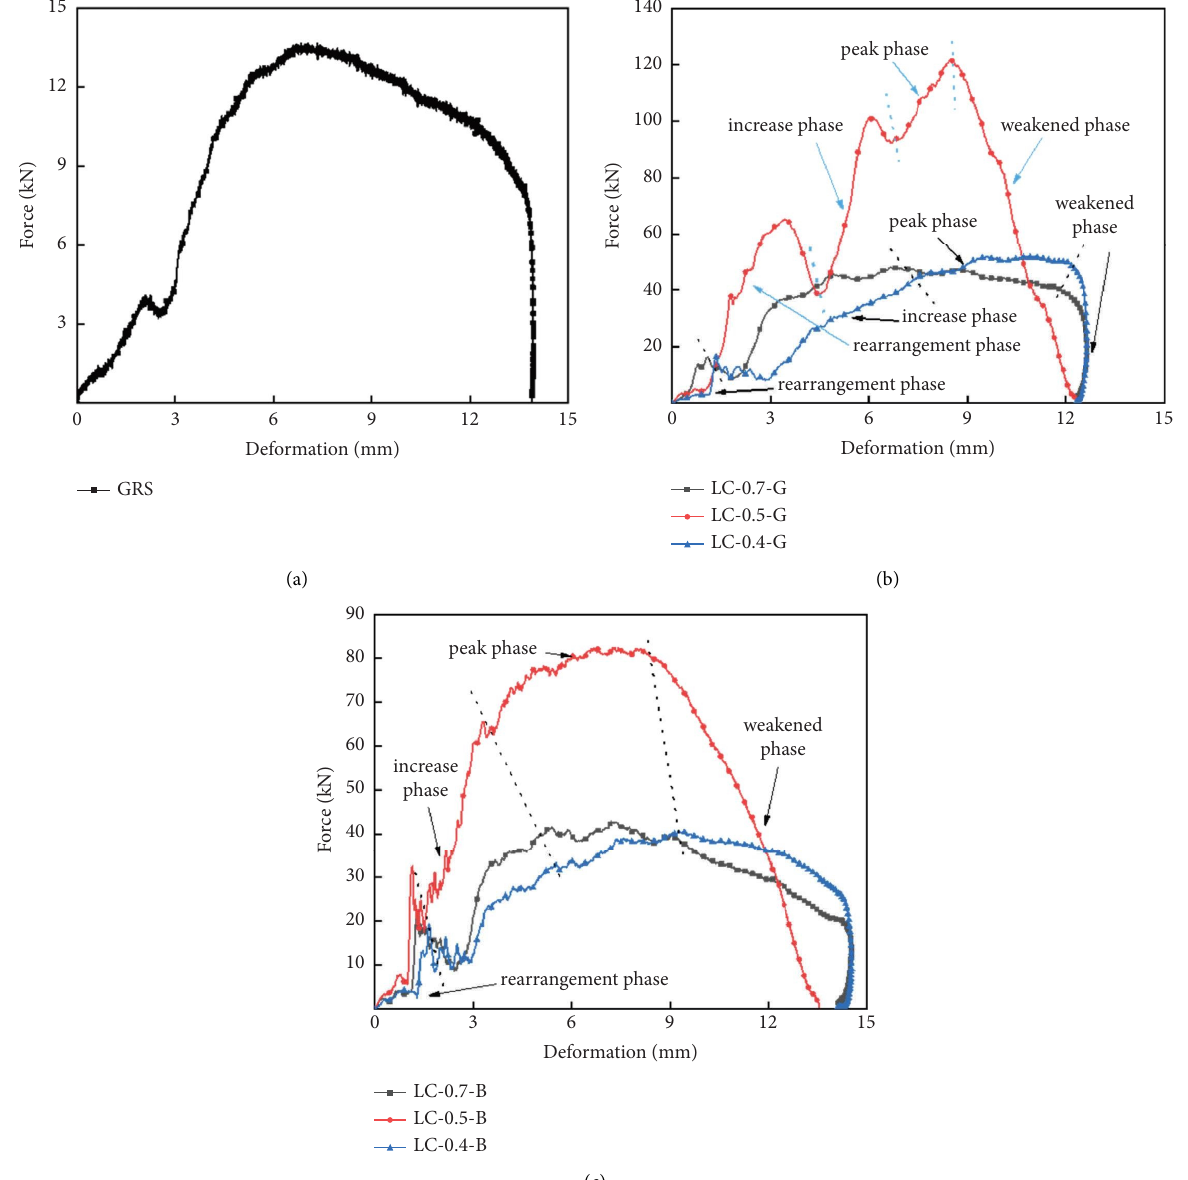
Figure 7: Te diagram of impact force and compression deformation of the